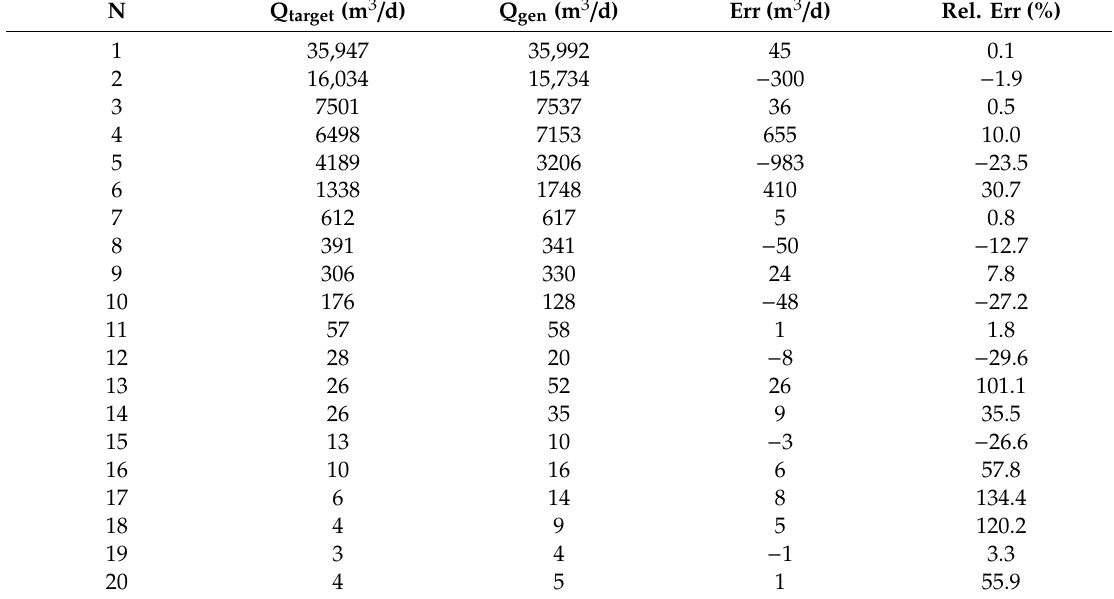
Table A2. Q target = wastewater target value, Q gen = generated wastewater inflow by OSM buildings, Err = absolute error; Rel. Err = relative error.